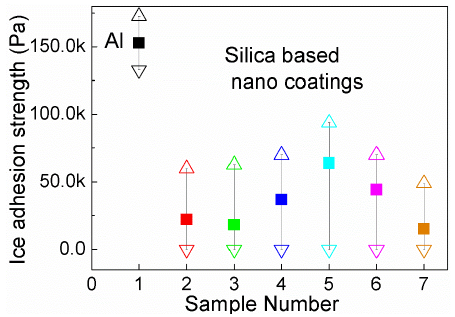
Figure 9. Ice adhesion results of silica-based nano-coatings on Al substrates (samples 2–7) and untreated Al surface (sample 1).